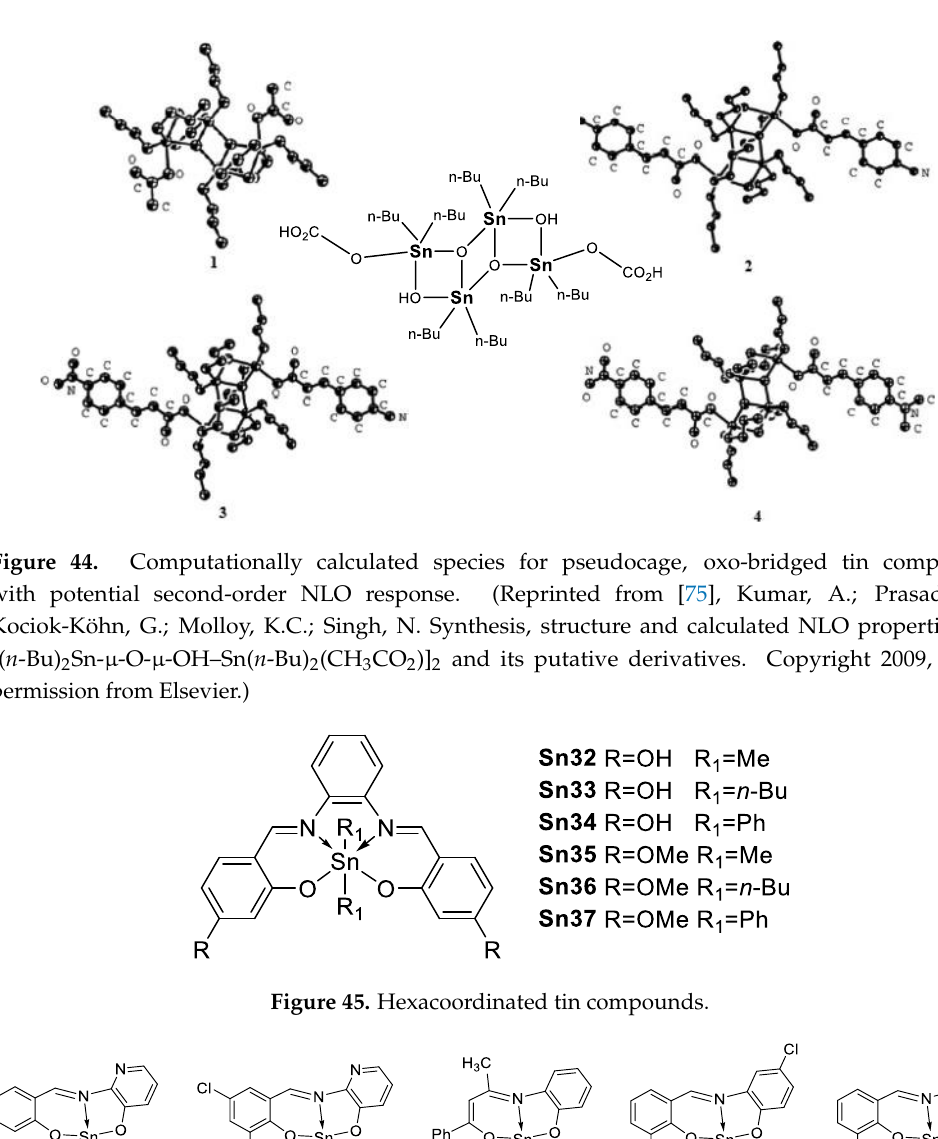
Table 5. Nonlinear optical properties for the hexacoordinated tin compounds.